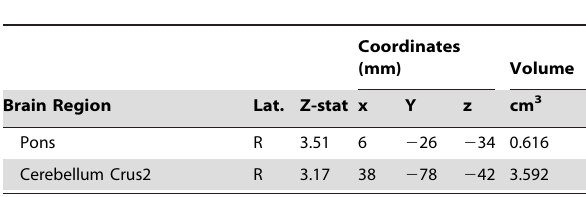
Table 3. Contrast analyses for Nalb-Sal vs Nalb-Nalox. Table 3. Cont.